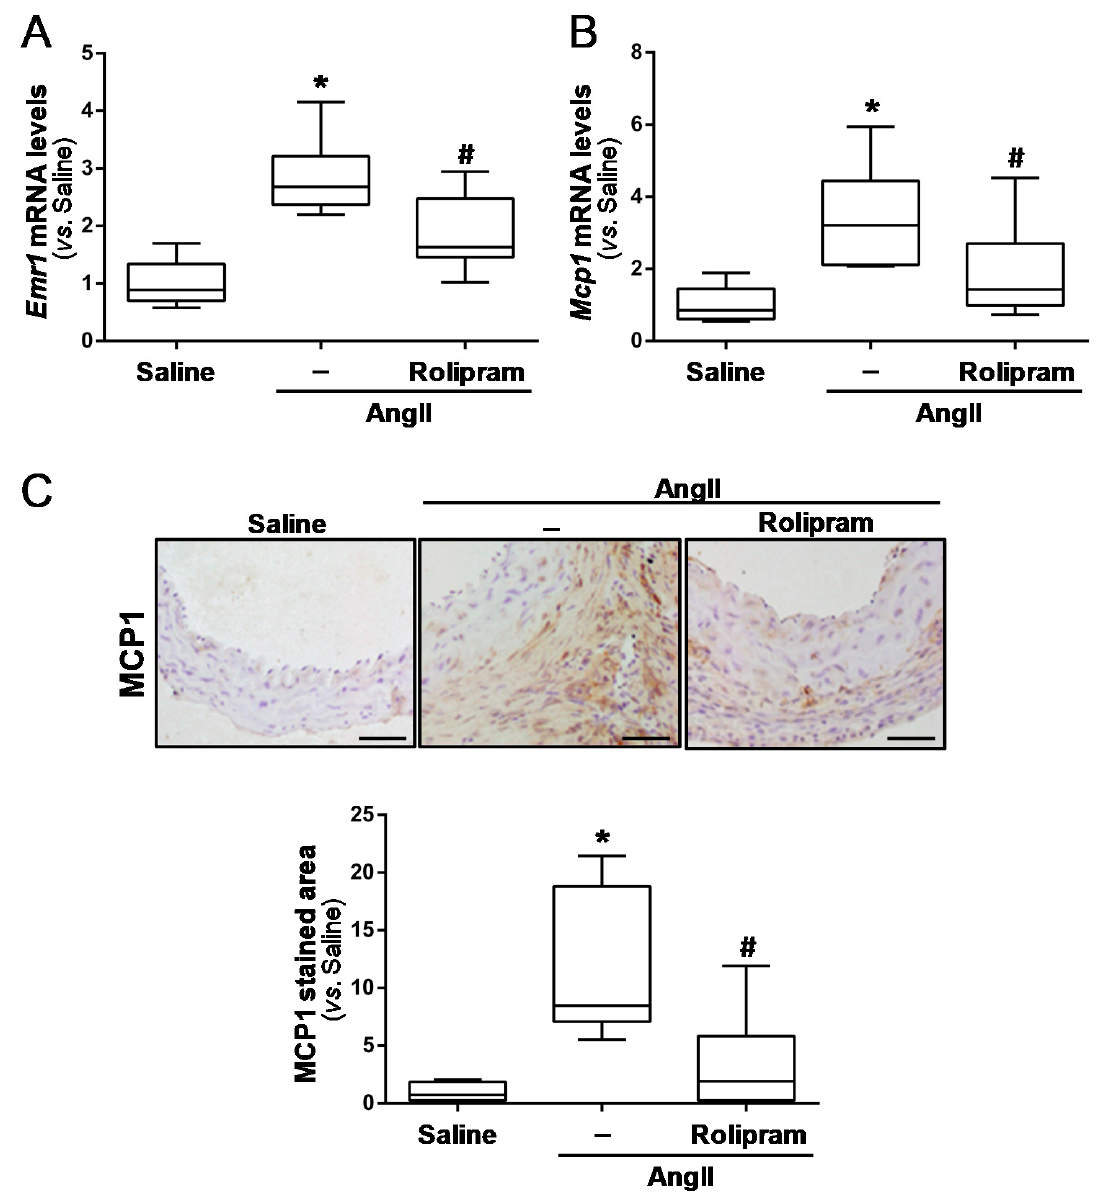
Figure 5. Rolipram limits the inflammatory response triggered by AngII in ApoE − / − mice. ApoE − / − mice were infused with saline solution or AngII (1000 ng/kg/min) for 28 days. Mice challenged with AngII were treated or not with rolipram (3 mg/kg/day). ( A , B ) The Emr1 ( A ) and Mcp1 ( B ) mRNA levels were analysed by real-time PCR (saline-infused mice n = 8; AngII-challenged mice, n = 12; AngII-challenged mice treated with rolipram, n = 9). ( C ) The immunohistochemical analysis of MCP1 expression in the abdominal aortas from each experimental group. Representative images are shown (Bar: 50 µ m; saline-infused mice n = 5; AngII-challenged mice, n = 8; AngII-challenged mice treated with rolipram, n = 6). The data are presented as box and whisker plots. The box extends from the 25th to the 75th percentile, and the median is indicated by a horizontal line. The whiskers represent the maximum and minimum values. In ( A – C ), p < 0.05: * vs. saline-infused mice; # vs. AngII-challenged mice.